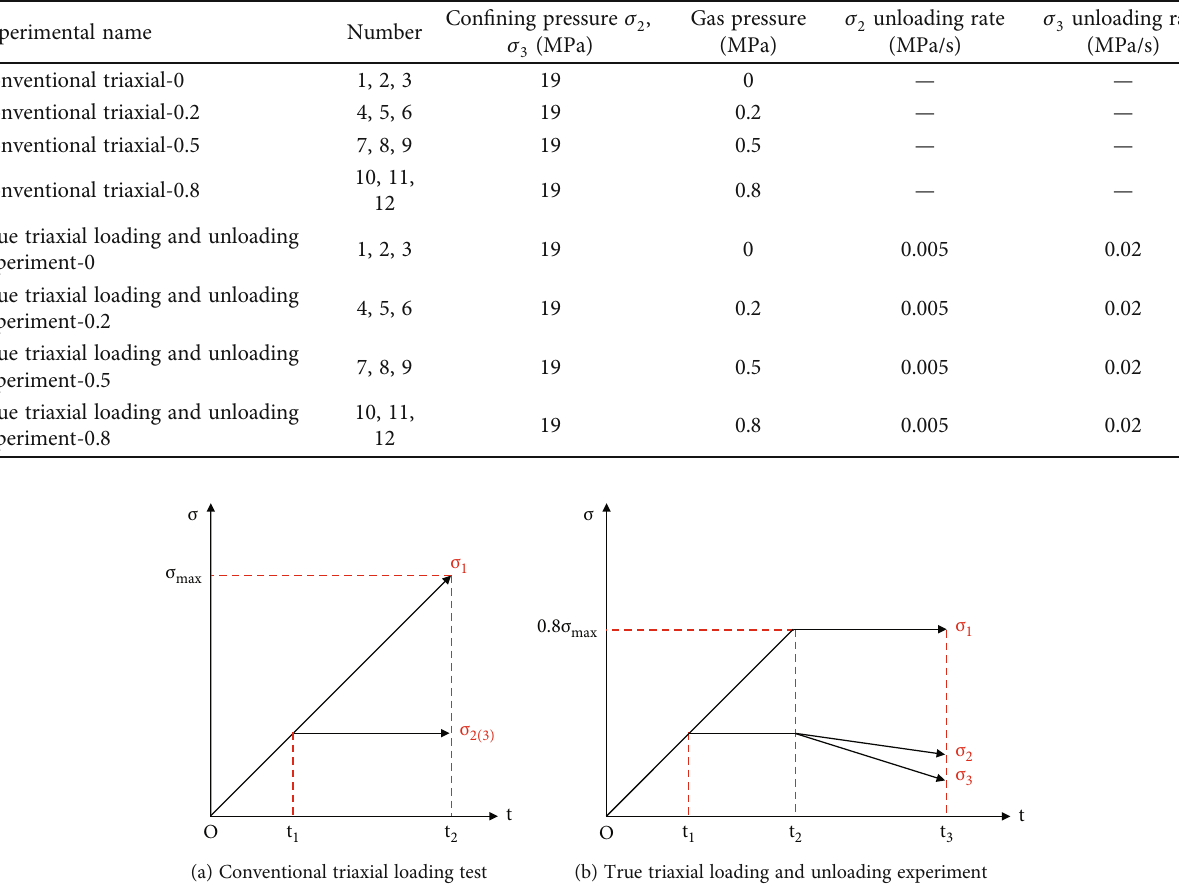
Figure 3: Stress path